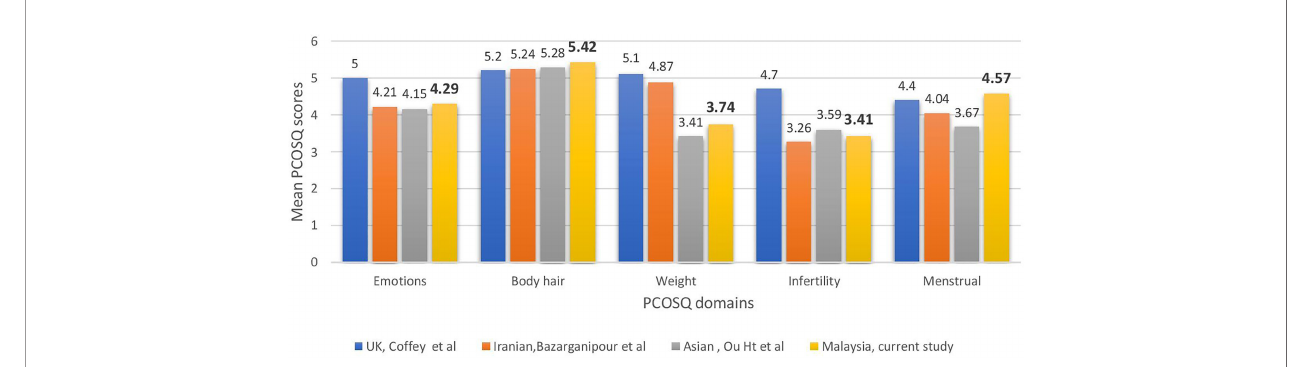
FIGURE 1 | Comparisons across countries in health-related quality of life of polycystic ovary syndrome women measured using the Polycystic Ovarian